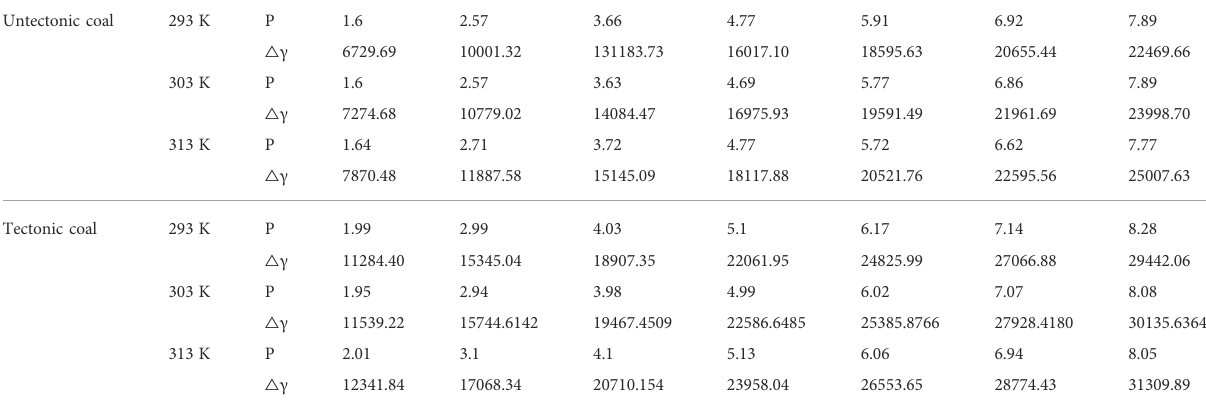
TABLE 1 Statistics of surface energy drop of tectonic/untectonic coal adsorbed methane at different temperatures (modi fi ed from Jian et al., 2014). Untectonic coal